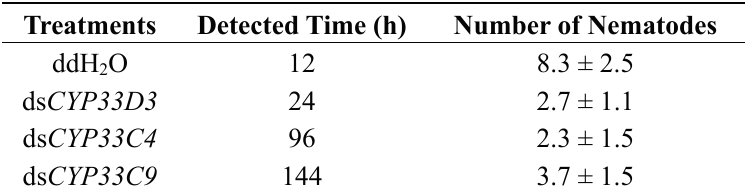
Table 1. Effect of RNAi to the dispersal ability of B. xylophilus